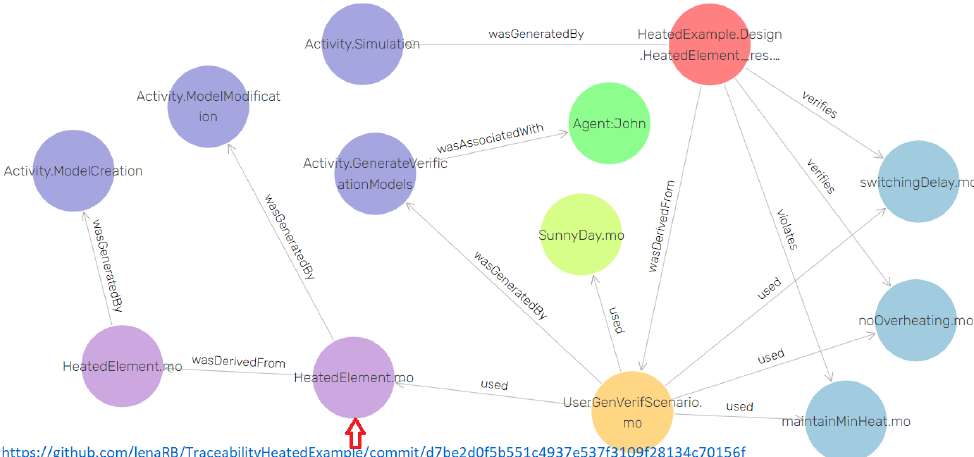
Figure 15. Traceability links showing the change impact of verification of the